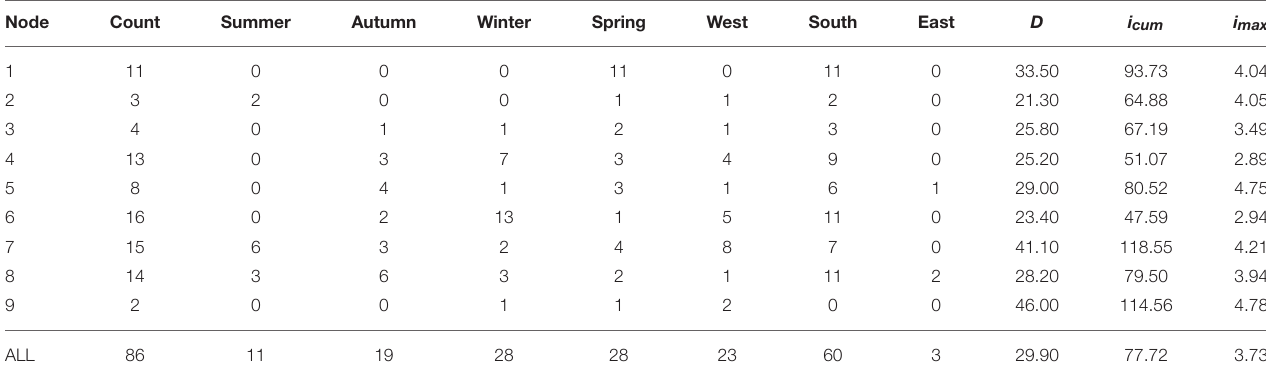
TABLE 2 | The count of MHWs clustered into each node, count of events for each season, count of events for each coast, and relevant metrics for those MHWs.